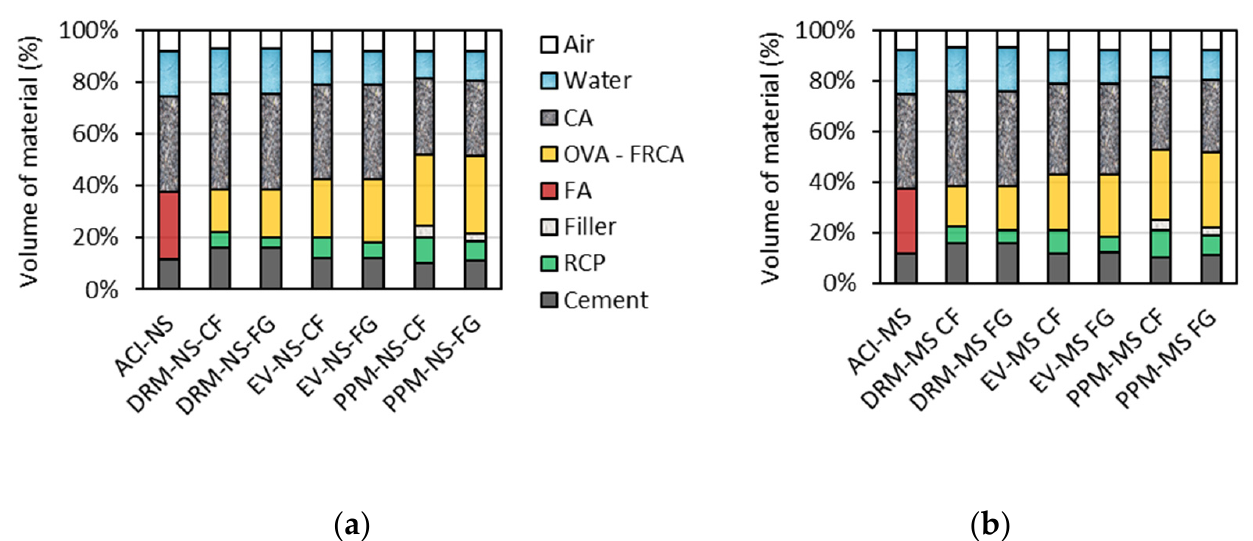
Figure 10. Volumetric fraction of each component for mixtures with FRCA made of NS ( a ) or MS ( b ).